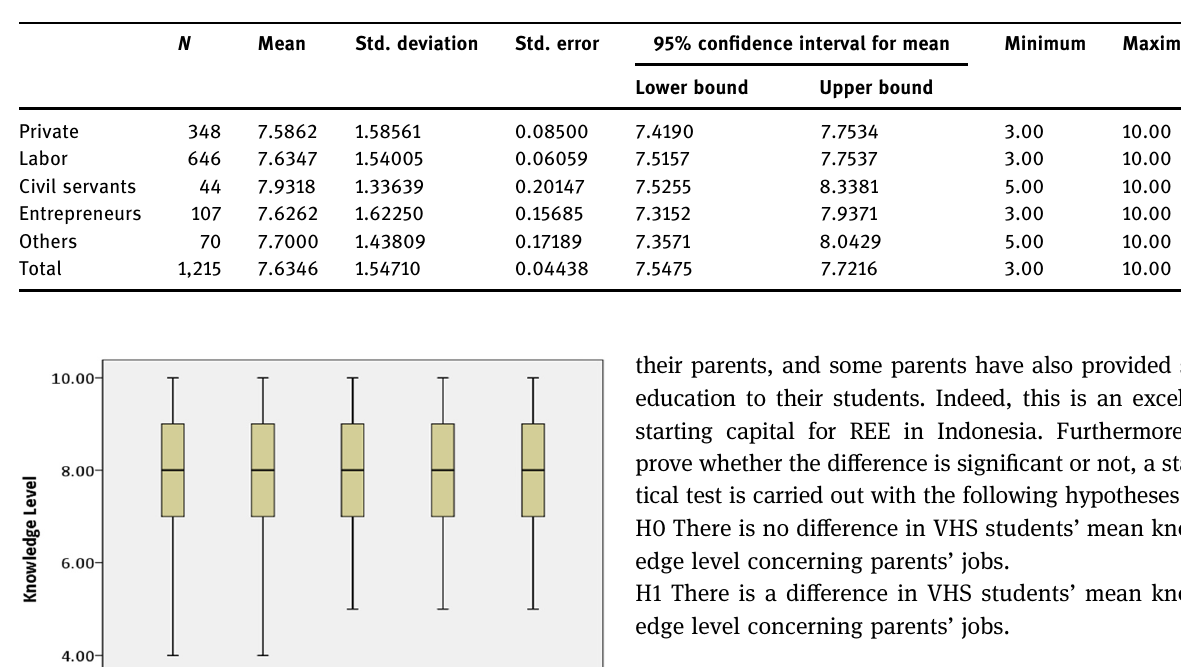
Table 7: Descriptive of knowledge level by parents ’ job